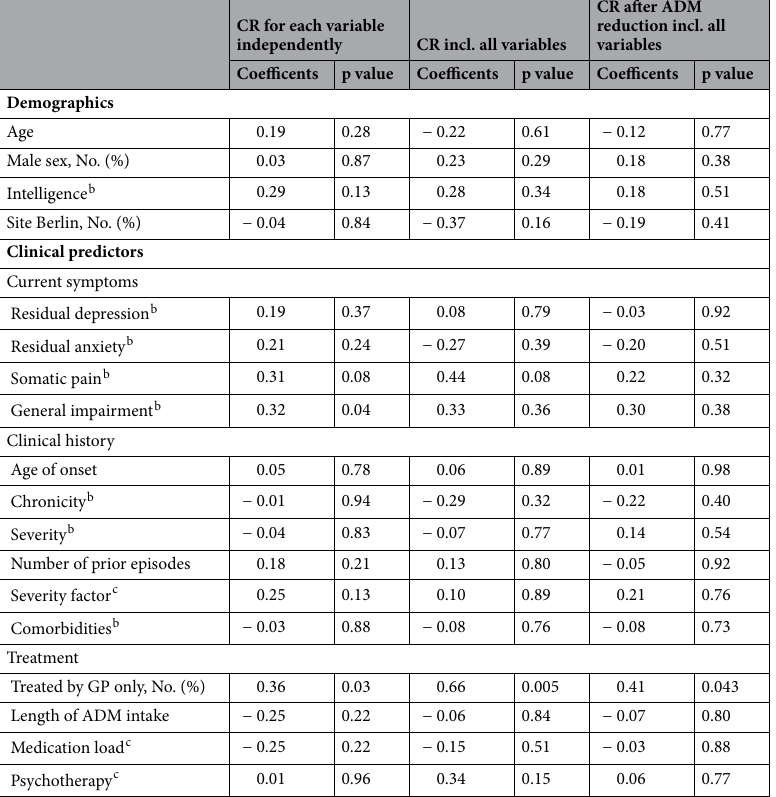
b Determined as follows: